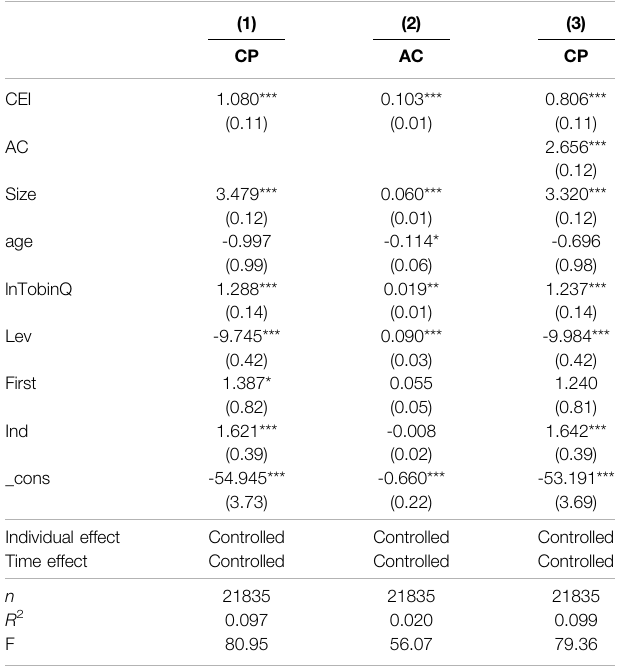
TABLE 9 | Principal-agent